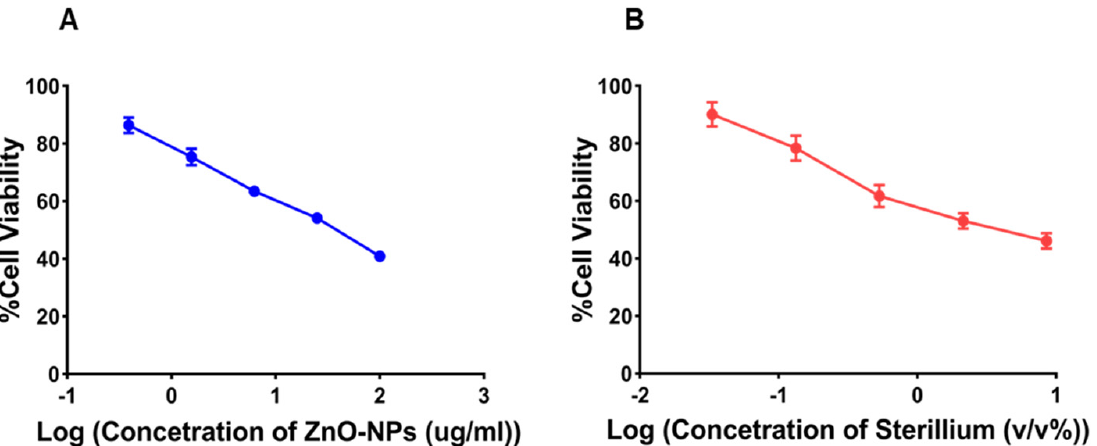
Figure 7. MTT cytotoxicity study of ( A ) ZnO-NPs and ( B ) a market product (Sterillium) on human dermal fibroblast cells. Each point is the average of two independent experiments, each performed in triplicate. Error bars represent standard deviation.